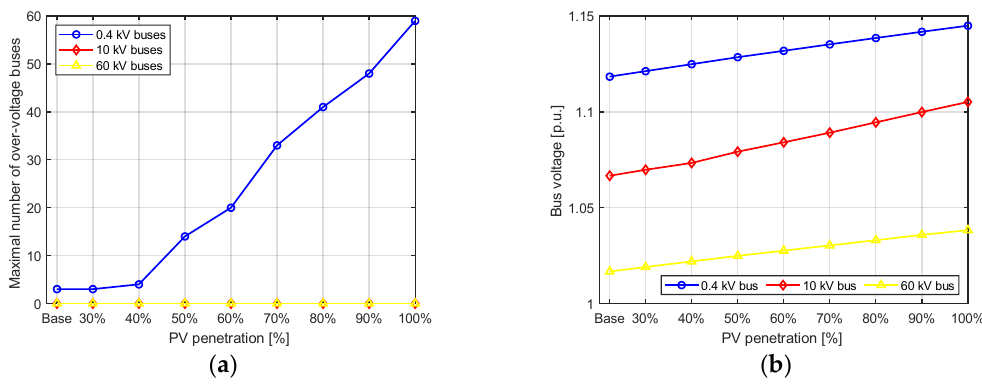
Figure 5. The worst overvoltage situations of buses at different penetration levels (with PF ( P )): ( a ) Yearly maximum number of overvoltage buses; ( b ) Yearly maximum bus voltage magnitude.